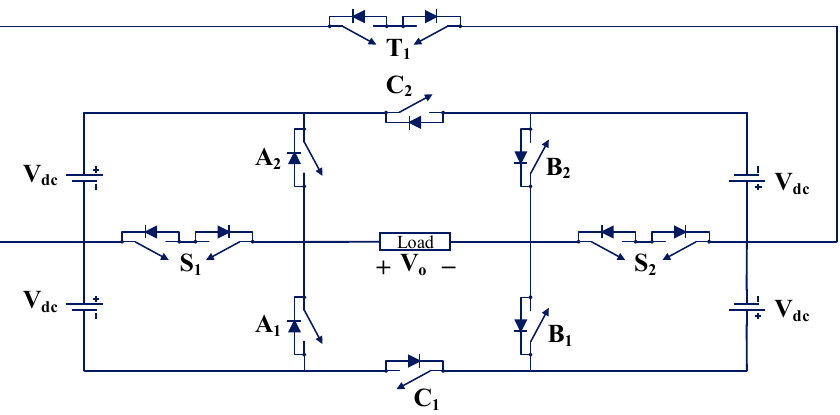
Figure 28. Single-phase nine-level FT MLI (TP31) [63].